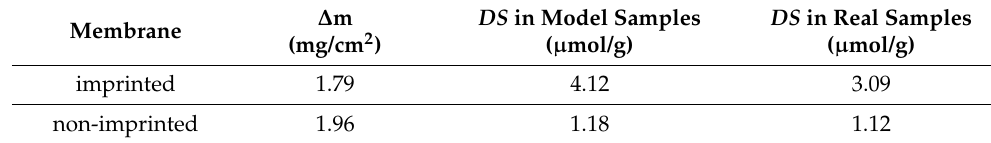
Table 4. Sorption properties of membranes tested in real and model conditions in dynamic sorption. Membrane